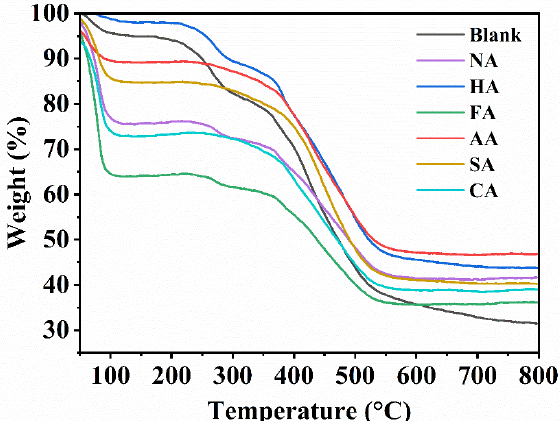
Figure 5. TGA curves of the blank sample and MIL-101 (Cr, Sn) synthesized with different modula-